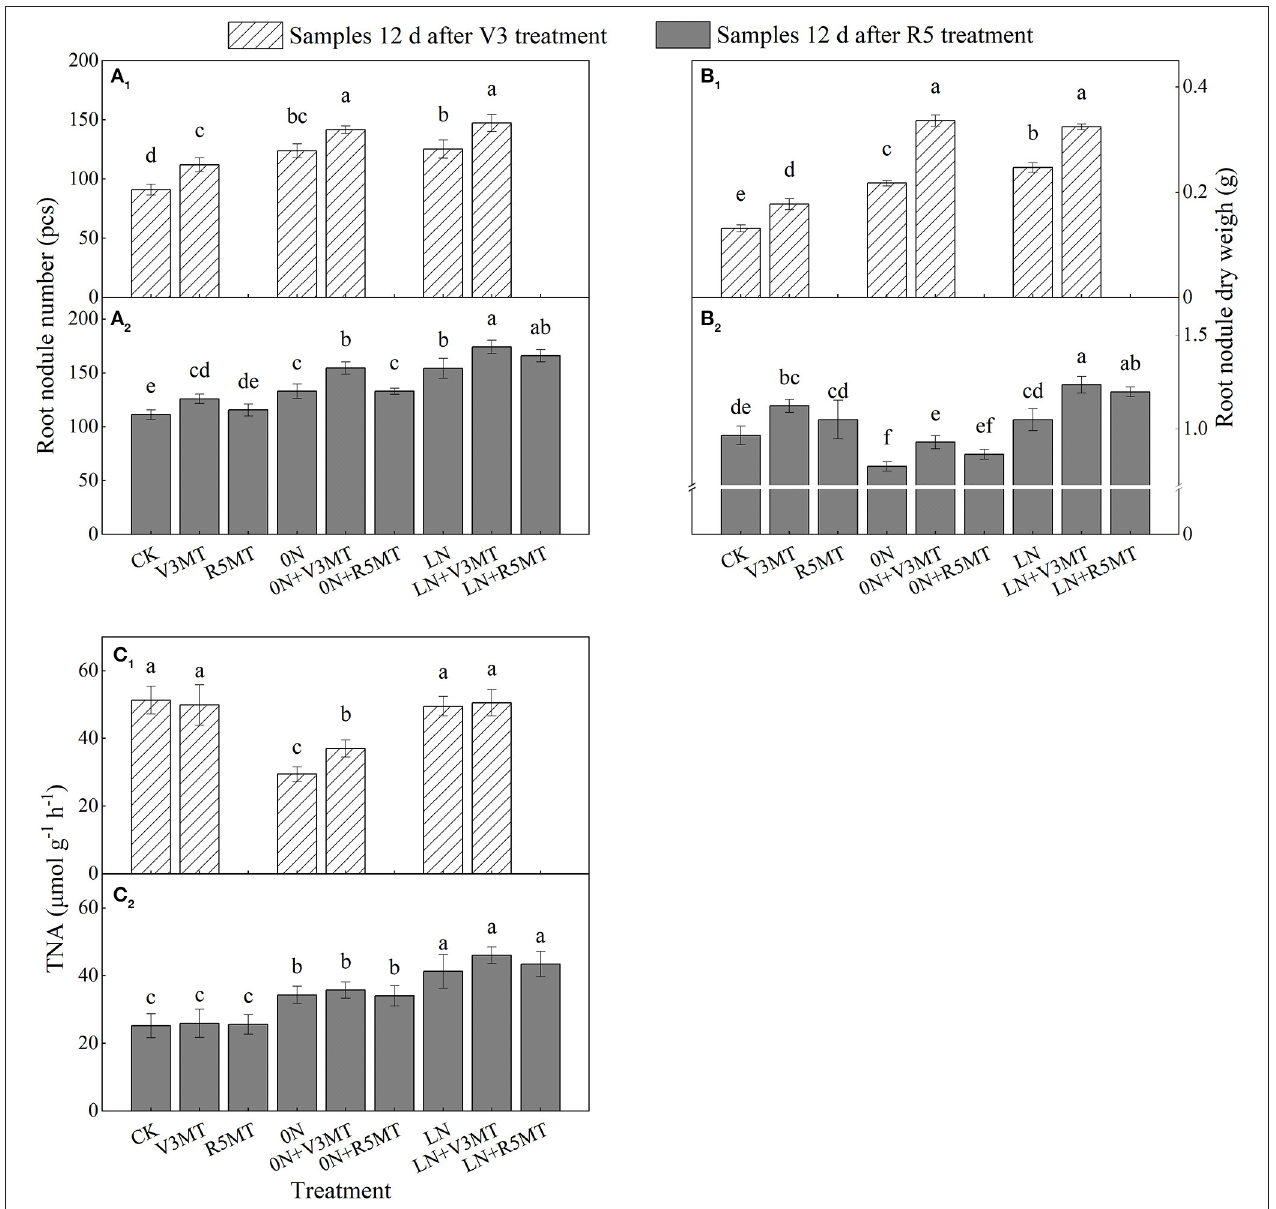
FIGURE 6 | The effect of exogenous melatonin (V3 and R5) on the number (A) , dry weight (B) , and nitrogenase activity (C) of root nodules under three N levels. The abbreviated meaning of each treatment is the same as in Figure 3 . The values were presented as mean ± SE ( n = 3). Different letters in one measuring group indicate statistically significant differences when P ≤